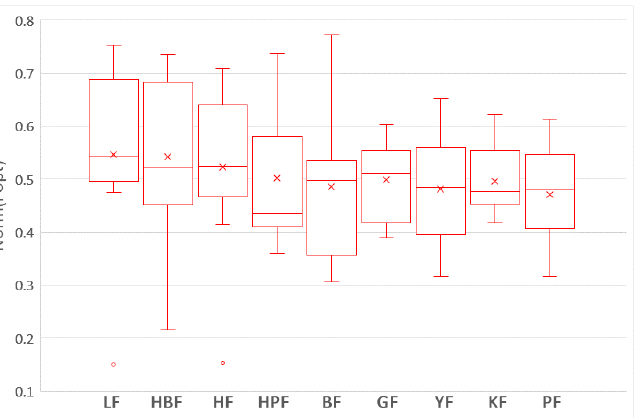
Figure 4. The boxplots of the nine training data selection methods with the Scott–Knott test results in terms of